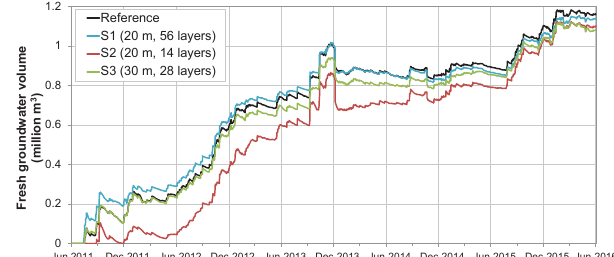
Figure 10. Simulated increase in the volume of fresh groundwater in the model domain from June 2011 to May 2016, for the refer- ence model (incl. wave setup and wave runup), model scenario A1 (constant MSL), and model scenario A2